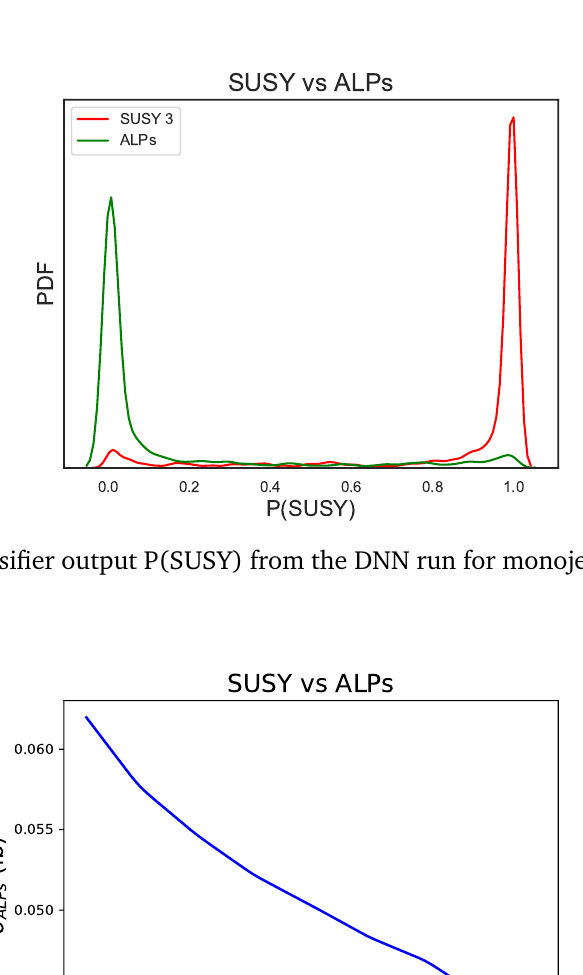
Figure 15: ALP cross-section bound for σ